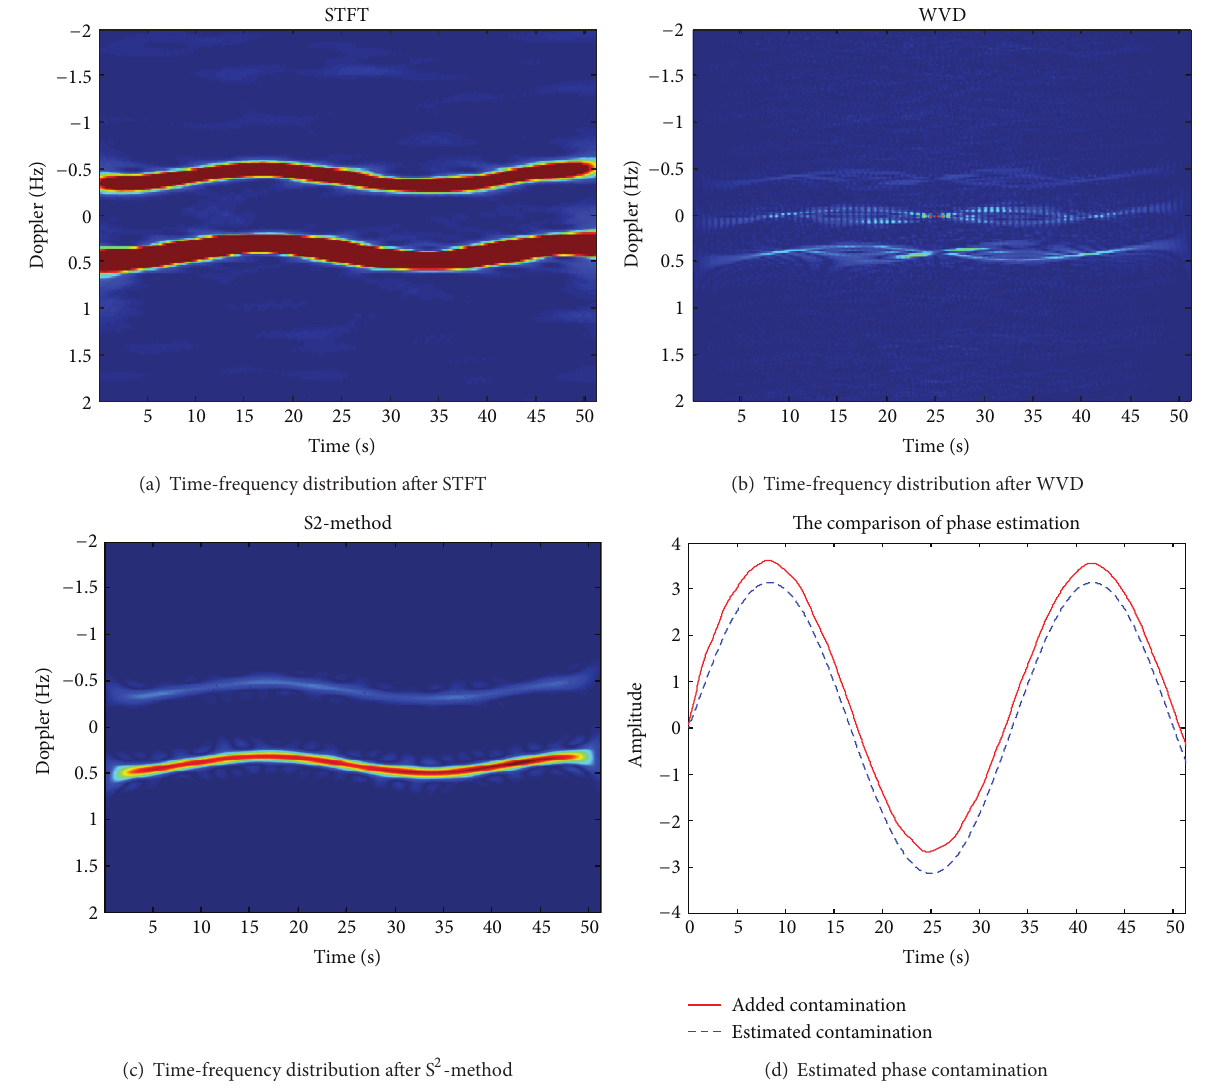
Figure 2: The time-frequency distribution of the contaminated sea clutter after STFT, WVD, and S 2 -method. The uncontaminated sea clutter spectrum